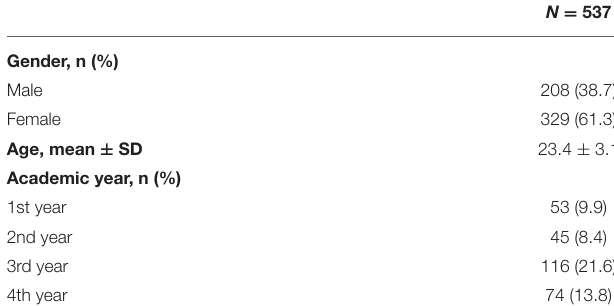
TABLE 1 | Medical students sample